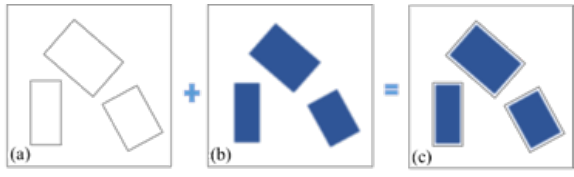
Figure 1. Ideal spatial enhancement procedure. (a) is the source image for spatial information input. (b) is the target image whose spectral information should be preserved. (c) represents the ideal pansharpened